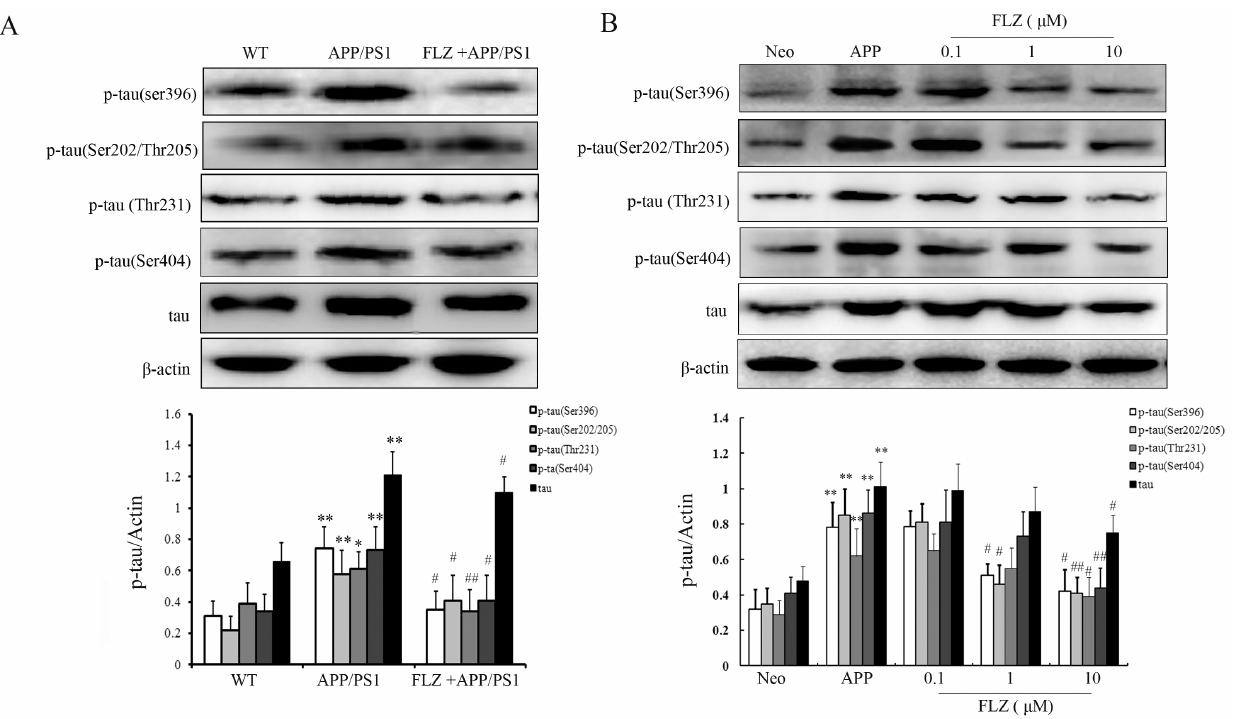
Figure 7. FLZ attenuated tau phosphorylation. APP/PS1 double transgenic mice were orally treated with FLZ 150 mg/kg for 20 weeks. SH-SY5Y (APPwt/swe) cells were grown in ‘‘stimulating medium’’ containing 50% DMEM, 50% Opti-MEM, 0.5% FBS, 200 m g/ml G418 and 10 mM butyric acid sodium salt for 12 h to induce the transgene expression. FLZ (0.1, 1 and 10 m M) were incubated with cells for 24 h. Antibodies against p-tau (Ser396), p-tau (Ser202/Thr205), p-tau (Thr231) and p-tau (Ser404) were subjected to Western blot assay. A representative immunoblot from 4 mice was shown. Results were expressed as mean 6 SD. (A) Western blot result in hippocampus of APP/PS1 mice. * P , 0.05, ** P , 0.01 vs . WT mice; # P , 0.05, ## P , 0.01 vs . APP/PS1 mice. (B) Western blot result of SH-SY5Y (APPwt/swe) cells. ** P , 0.01 vs . Neo SH-SY5Y cells, # P , 0.05, ## P , 0.01 vs . solvent-treated SH-SY5Y (APPwt/swe) cells.